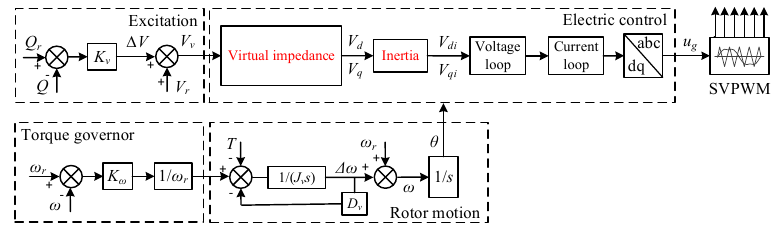
Figure 2. Schematic diagram of improved VSG control.